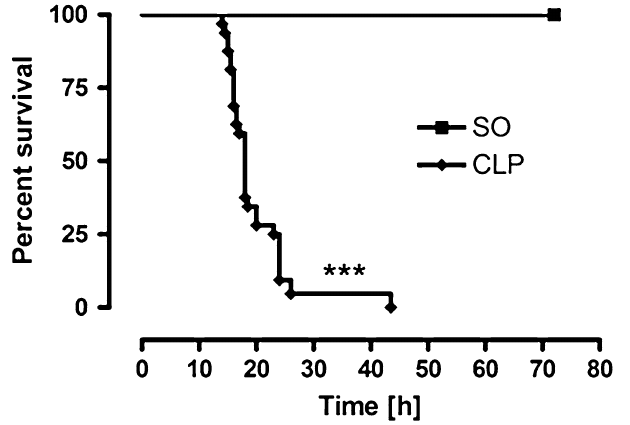
Figure 1. Effect of sepsis on survival time in mice. Sepsis (CLP) significantly ( p < 0.001) reduced the mean survival time in septic mice (19.97 ± 1.04 h; n = 30) in comparison to the sham-operated (SO) mice. All the SO mice (n = 12) survived during the 72 h observation period. The overall difference in survival rate was determined by the Kaplan–Meier test followed by the log-rank test. * p < 0.001 vs.